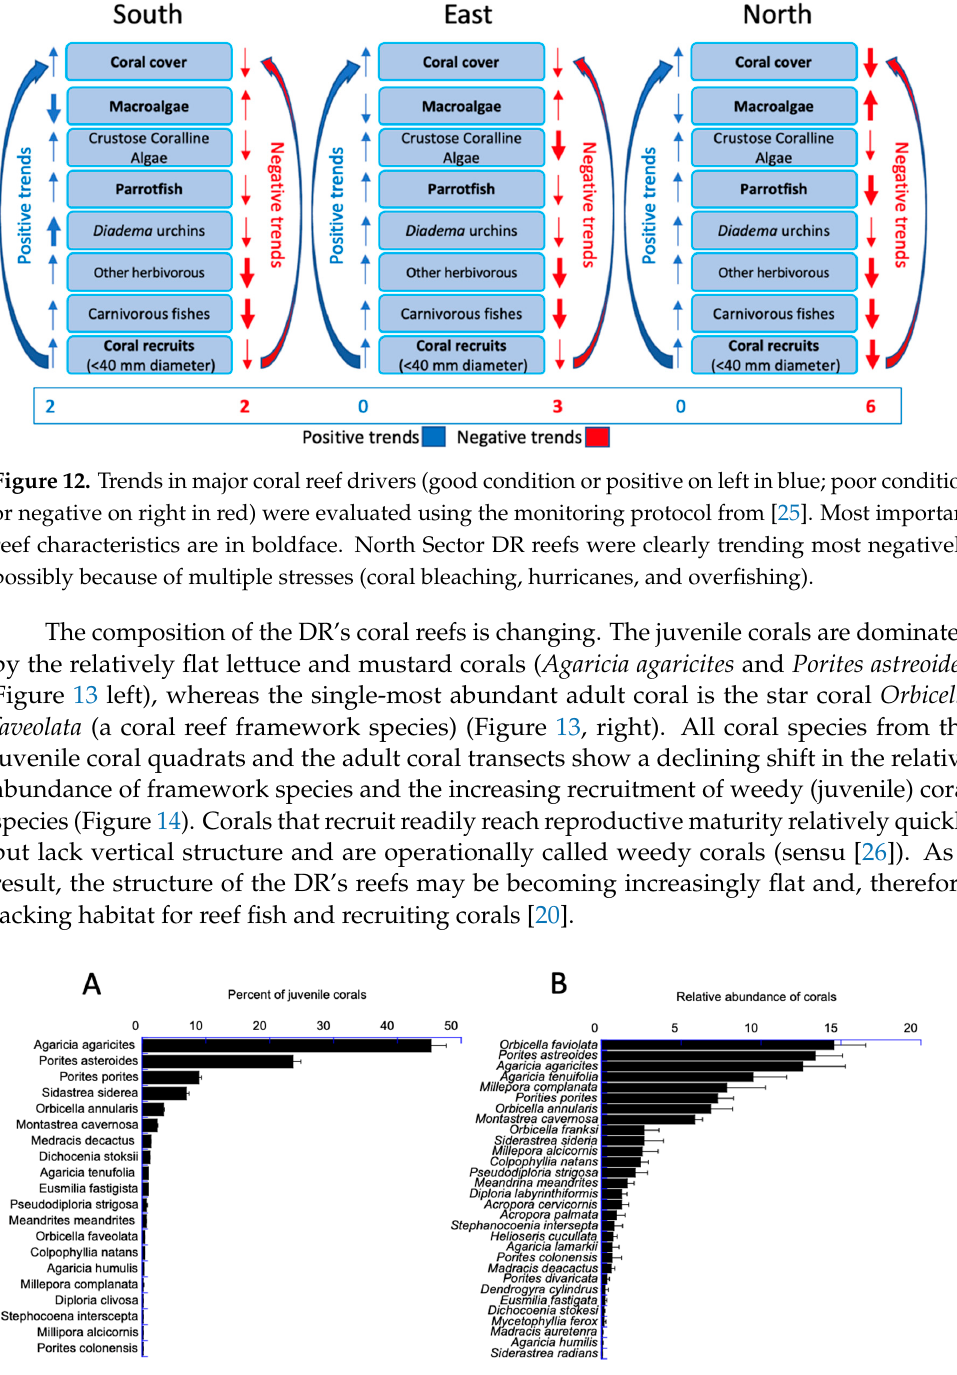
Figure 14. Trends in recruiting (“weedy”) and framework species. 4. Conclusions Since monitoring began in 2015, the coral reefs along the DR’s north shore have de- clined the most steeply. The greatest changes have occurred in the Montecristi Region. Those reefs, in 2015, were among the best in the Caribbean in terms of high coral cover, low algal biomass, abundant parrotfish, and abundant juvenile corals (compared with Eastern Caribbean and Belize [6,7], respectively. In 2015, there were large stands of acroporid corals (elkhorn and staghorn corals) along with branching leafy coral ( Agaricia tenuifolia ) (see Figure S2). However, in late summer of 2016 and September of 2017, a coral bleaching event and two hurricanes, respectively, killed corals in the Montecristi region (Figure S2). Those events, along with sustained fishing pressure (Figure 8B), seem to have contributed to the declines in corals and herbivorous fishes and increases in macroalgae